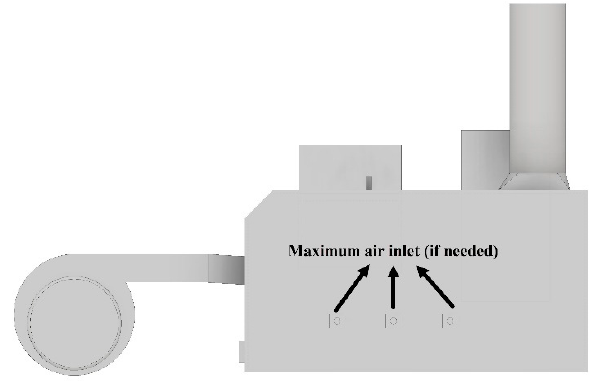
Figure 2. Side view of the portable incinerator.